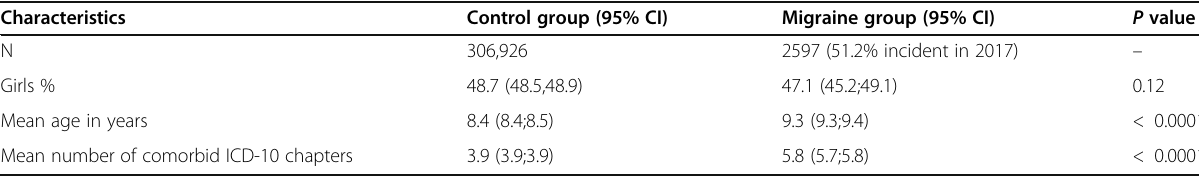
Table 1 Characteristics of the study population. CI: confidence interval Characteristics